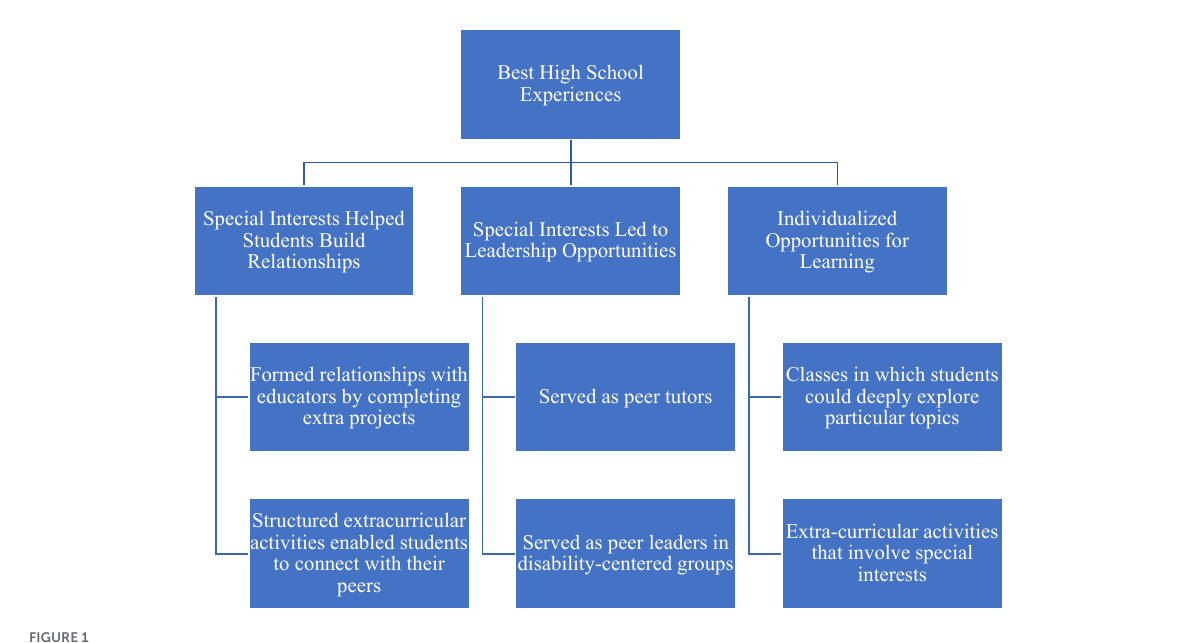
FIGURE1 Coding map of the best high school